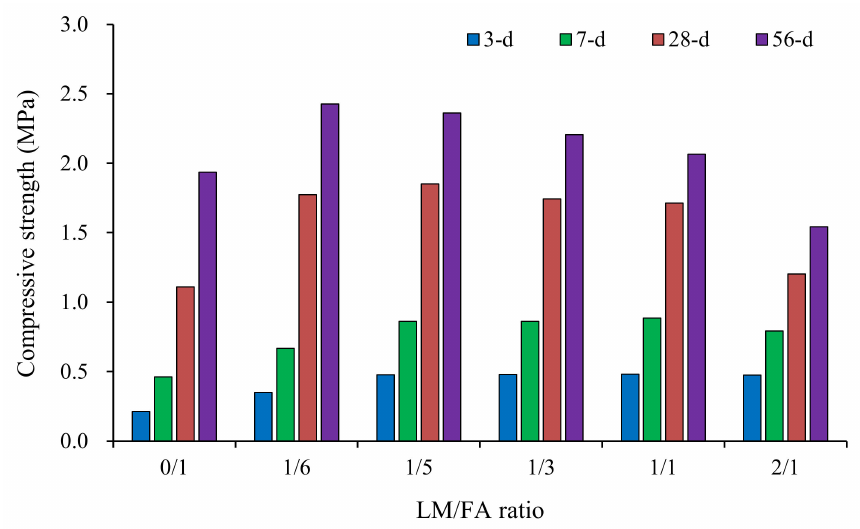
Figure 3. Compressive strengths of Series I mixtures.